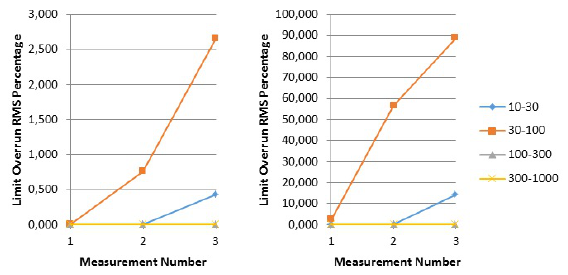
Figure 7. comparison of RMS values [%] (to the left the measuring point in front of the tunnel A and to the right the measuring point in front of the tunnel B in location